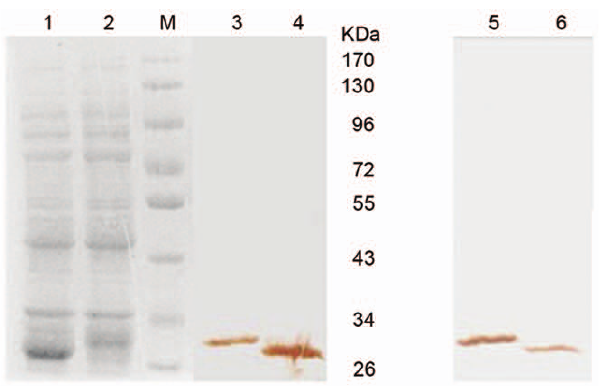
Figure 4. SDS-PAGE assay and immunoblot analysis of the two random selected soluble anti-DES scFvs (approximately 30 kDa). Lane M: protein standards; lane 1, 2: SDS–PAGE analysis of the induced whole cellular lysate; lane 3, 4: Western blotting analysis of the induced whole cellular lysate; lane5, 6: Western blotting analysis of cellular